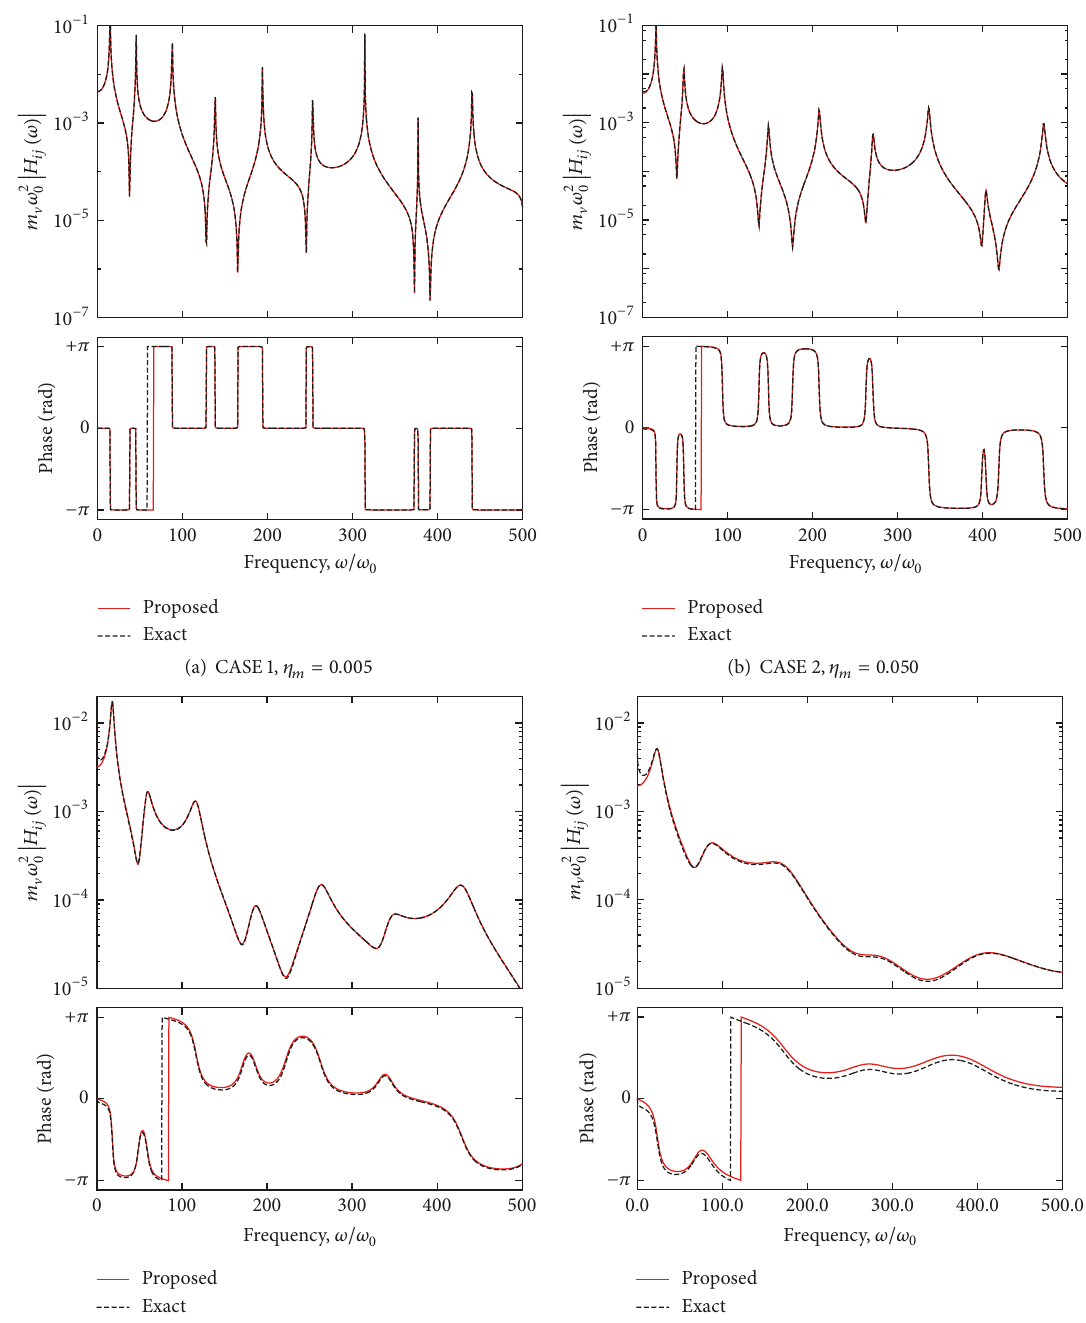
Figure 5: Example 2: viscoelastic 1D structures. Frequency response functions of viscoelastic (exact) and viscous (proposed) system. The four cases covered in Table 1 are represented from plots (a) to (d),